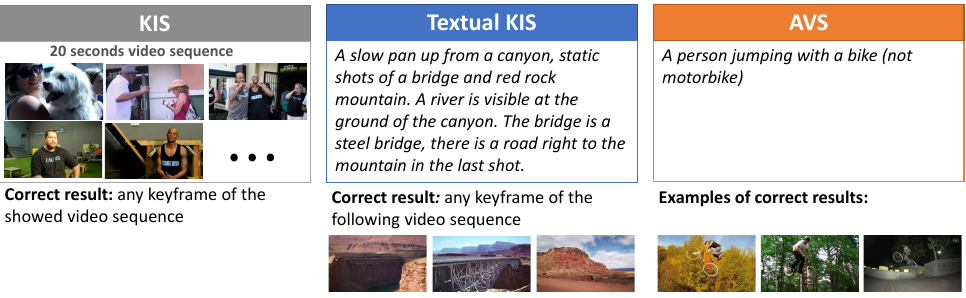
Figure 1. Examples of KIS, textual KIS and AVS